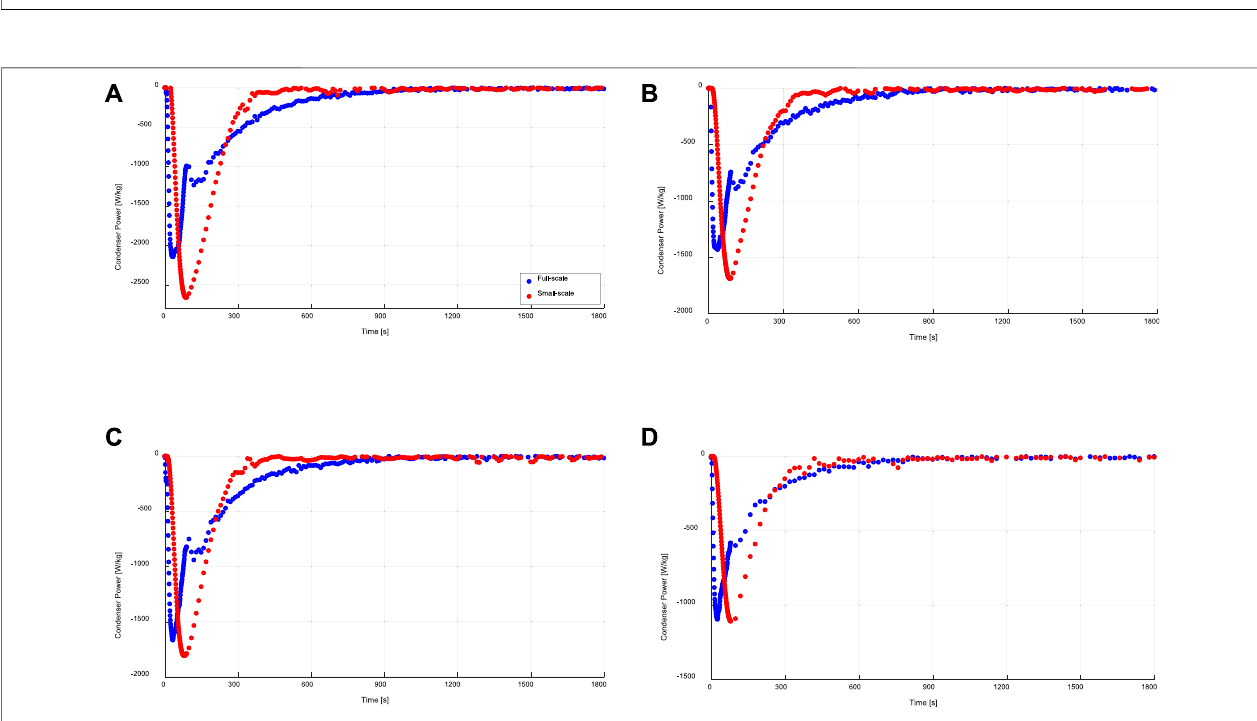
FIGURE 8 | Instantaneous speci fi c condensation power of the evaporator/condenser unit (full-scale) and that estimated from the kinetic results of the adsorbent sample (small-scale), at (A) 15/30/90 ° C, (B) 15/35/90 ° C, (C) 10/30/90 ° C, (C) 10/35/90 ° C.